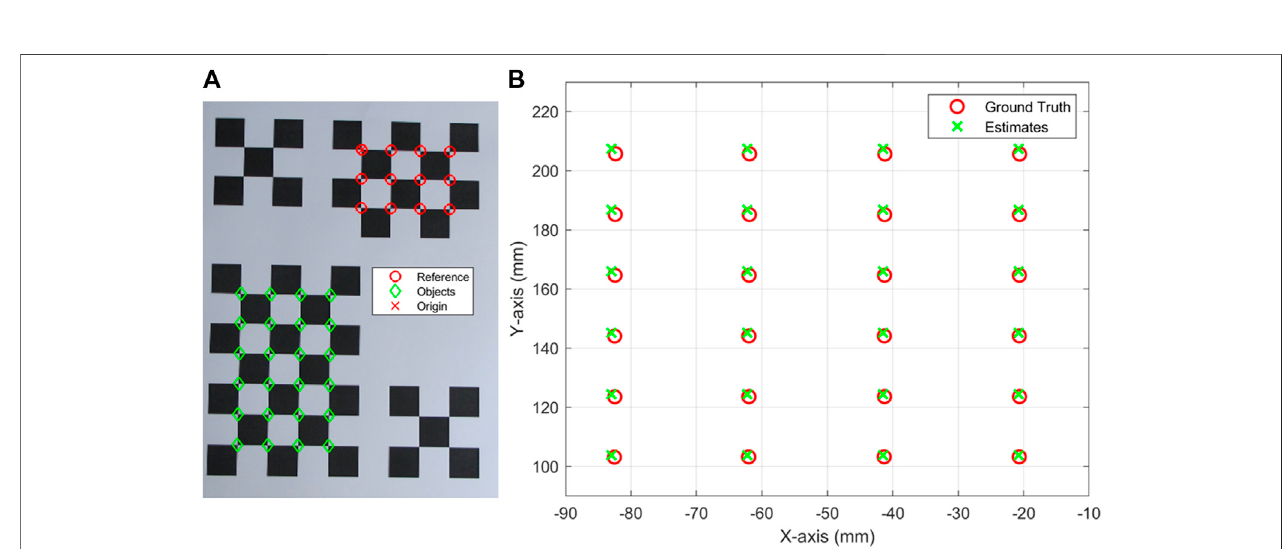
FIGURE 3 | The repeated measurements of the insertion force on a channel has the two-bend shape.